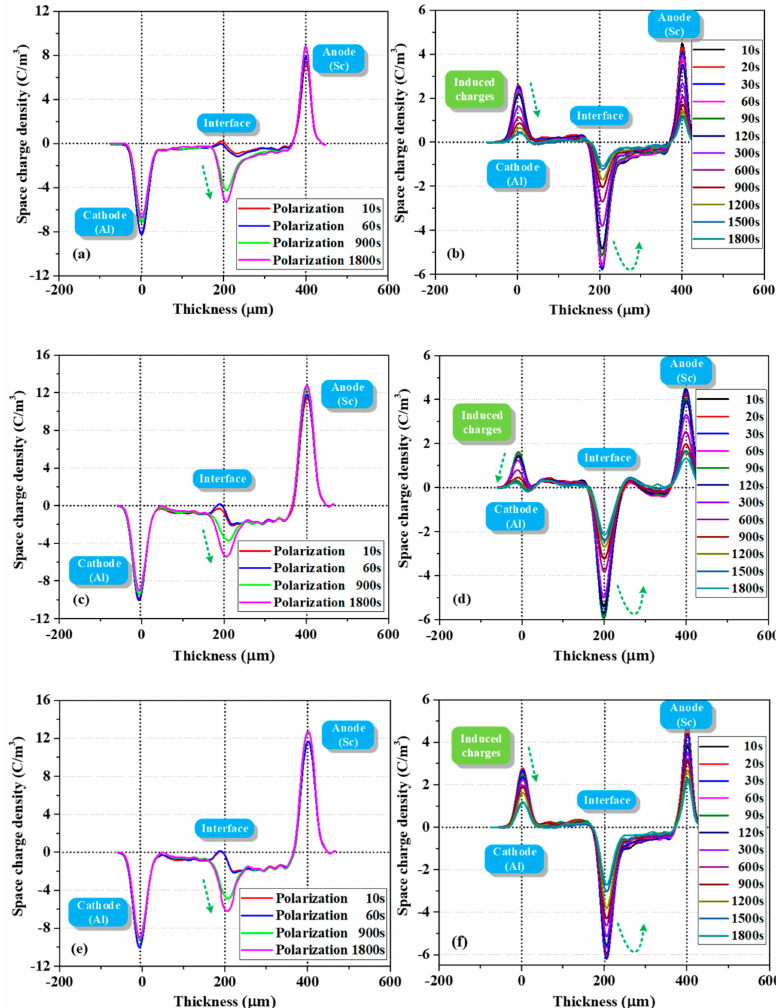
Figure 4. Evolution of space charge during polarization (left) and depolarization (right) processes of PET–PET samples with di ff erent thermal aging degrees (measured by PEA). Samples thermally aged for ( a , b ) 720, ( c , d ) 2100, and ( e , f ) 2900